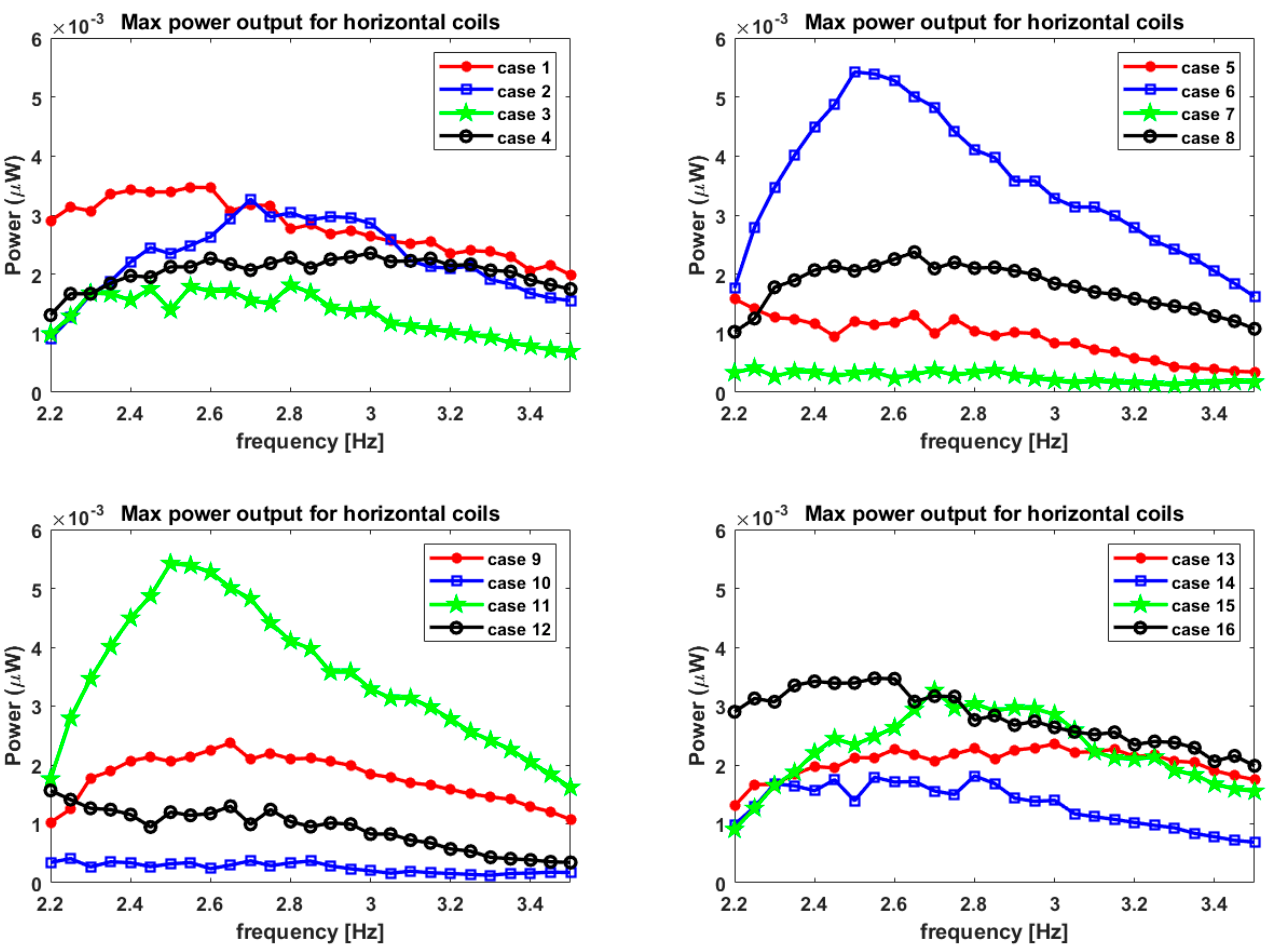
Figure 18. Maximum power output from horizontal winding for L = 5 cm tank. The maximum power obtained is 0.005 micro-watts ( 𝛍𝐖 ) or 0.5 (cid:4672) case 11. Here too, the symmetry observed for the max voltages is evident. The maximum power value is obtained for a frequency of 2.5 Hz, pointing towards shifting the peak from the first modal frequency of 2.96 Hz. This again can be attributed to the magnetic body force exerted on the fluid in the y -direction. Here, the frequency for peak power shifts to the left of the modal frequency for the horizontal winding, unlike the L = 10 cm tank case where the frequency shifted towards the right. cases is plotted in Figure 19. The maximum power is obtained at 2.8 Hz for case 7 (and case 10) and is almost near to 0.7 micro-watts ( 𝛍𝐖 ) or 70 (cid:4672)